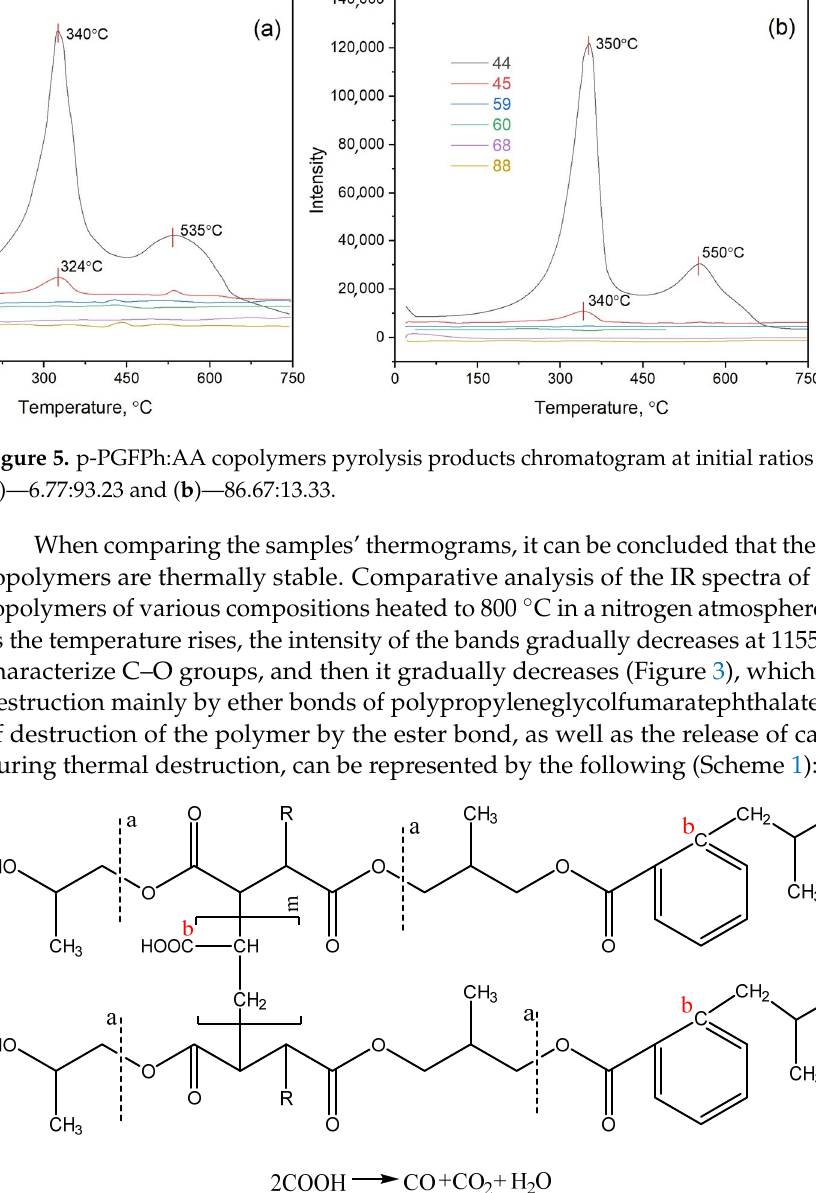
7 of 17 Table 1. p-PGFPh:АА copolymers heat capacity at different ratios, at heating rate 10 °С/min. Sample